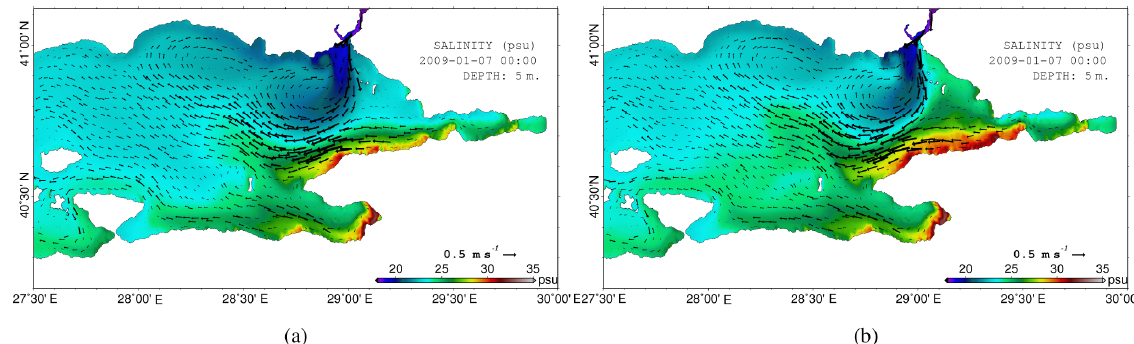
Figure 13. Salinity overlaid with current fields at 5m depth, obtained from experiments (a) FB001 and (b) FB002 on 7 January 2009 at